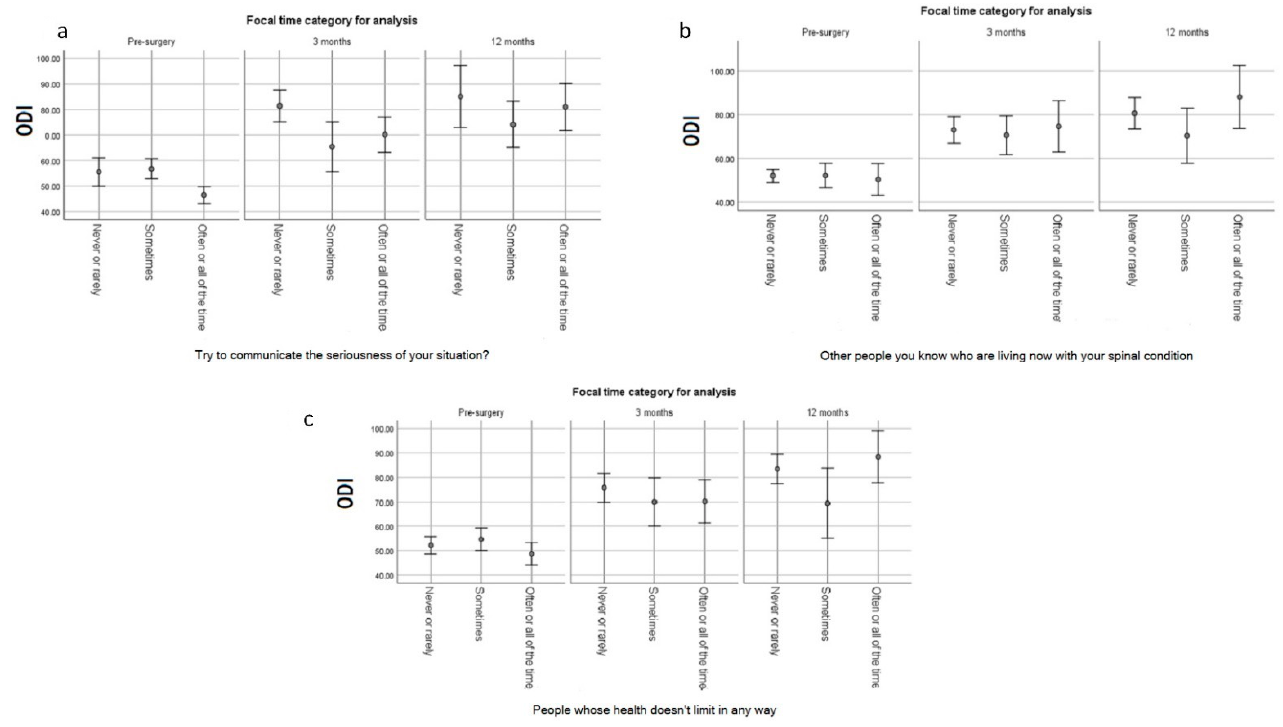
Figure 3. Relationship of Appraisal with ODI Over Time ( a – c ).